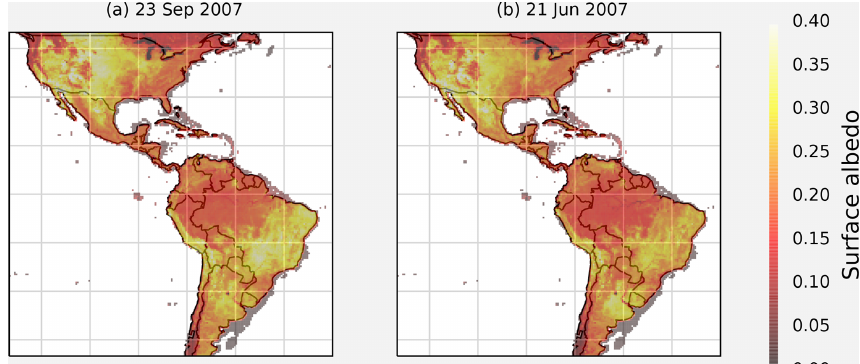
Figure 4. Comparing surface albedo during the autumn equinox (a) and the summer solstice (b)